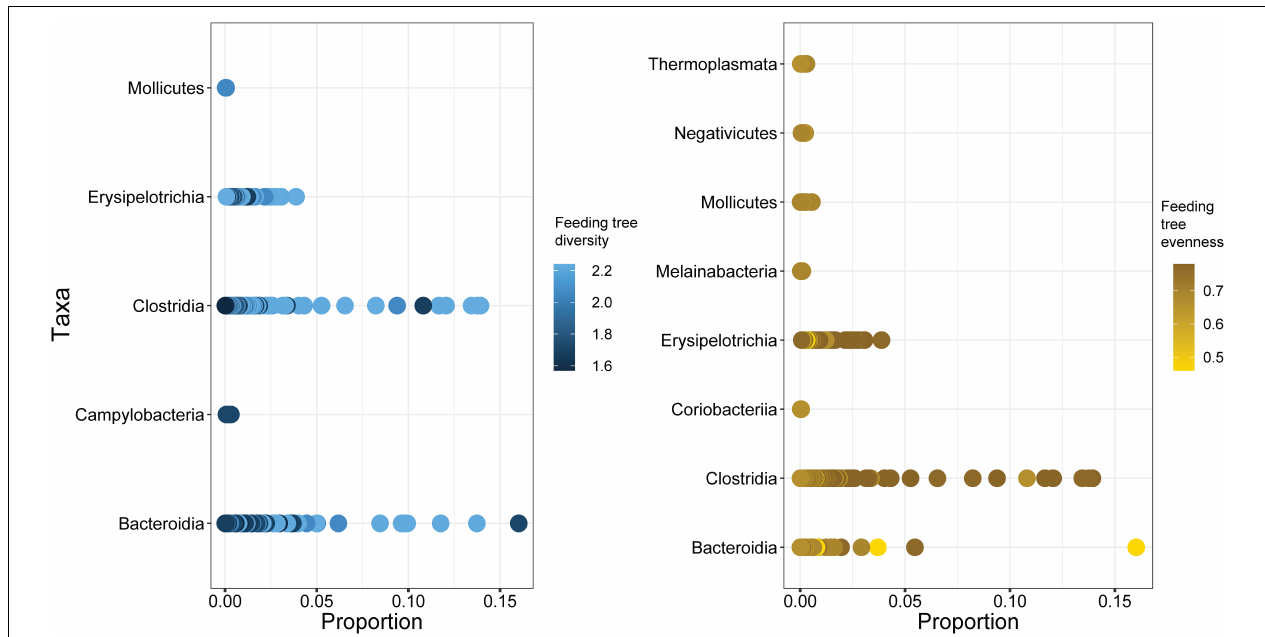
FIGURE 5 | Changes in proportional abundance of bacterial taxa of black howler monkeys ( Alouatta pigra ) related to variation in measures of food availability (i.e., feeding tree diversity and